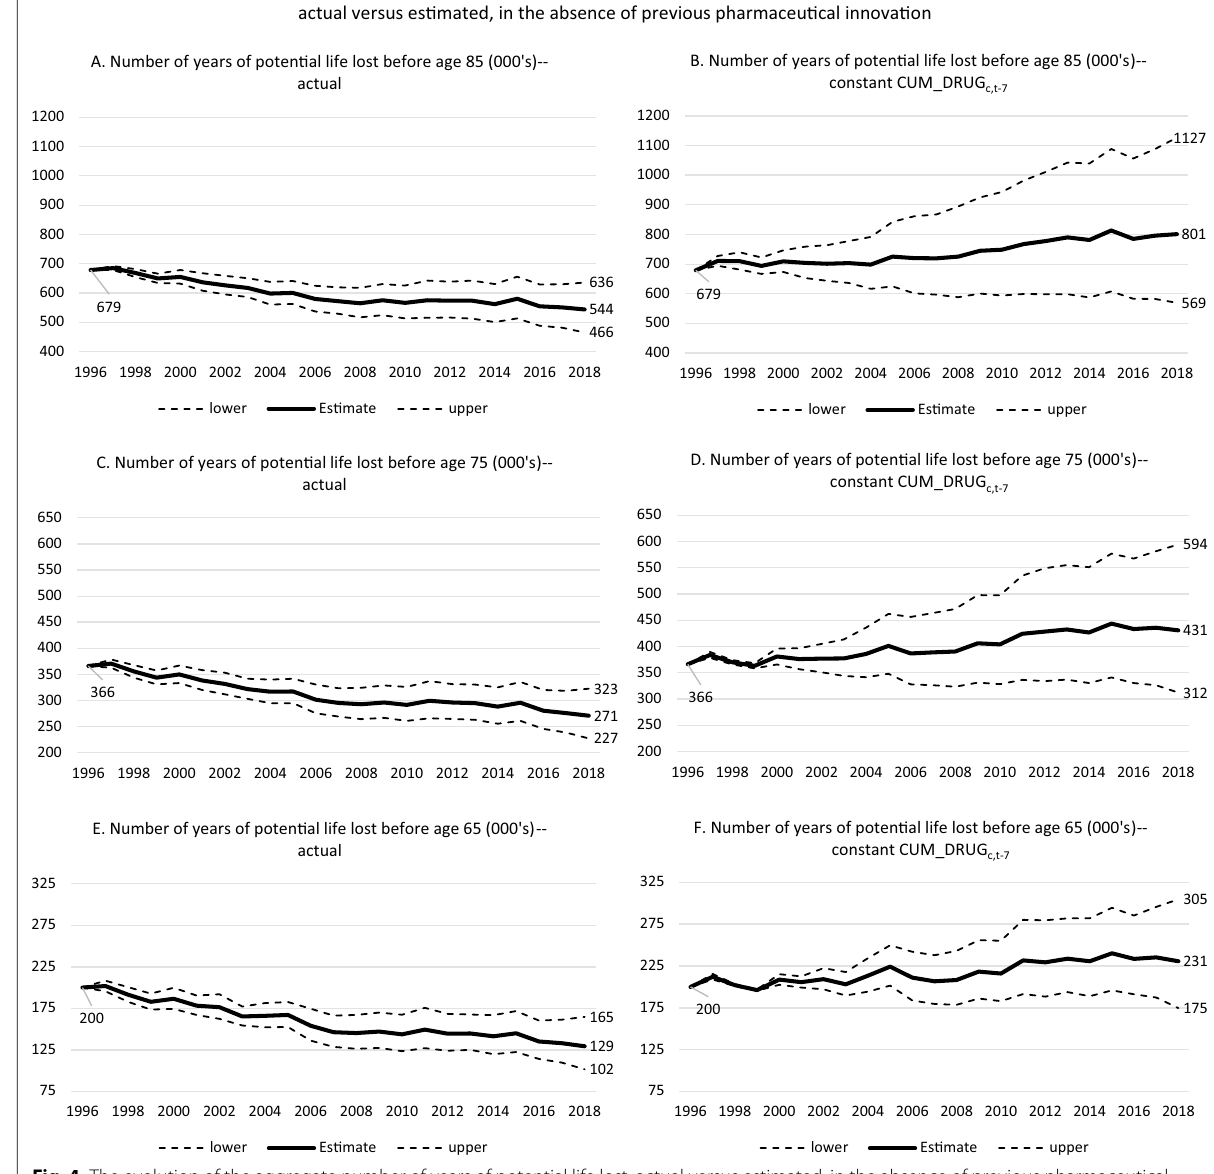
Fig. 4 The evolution of the aggregate number of years of potential life lost: actual versus estimated, in the absence of previous pharmaceutical innovation